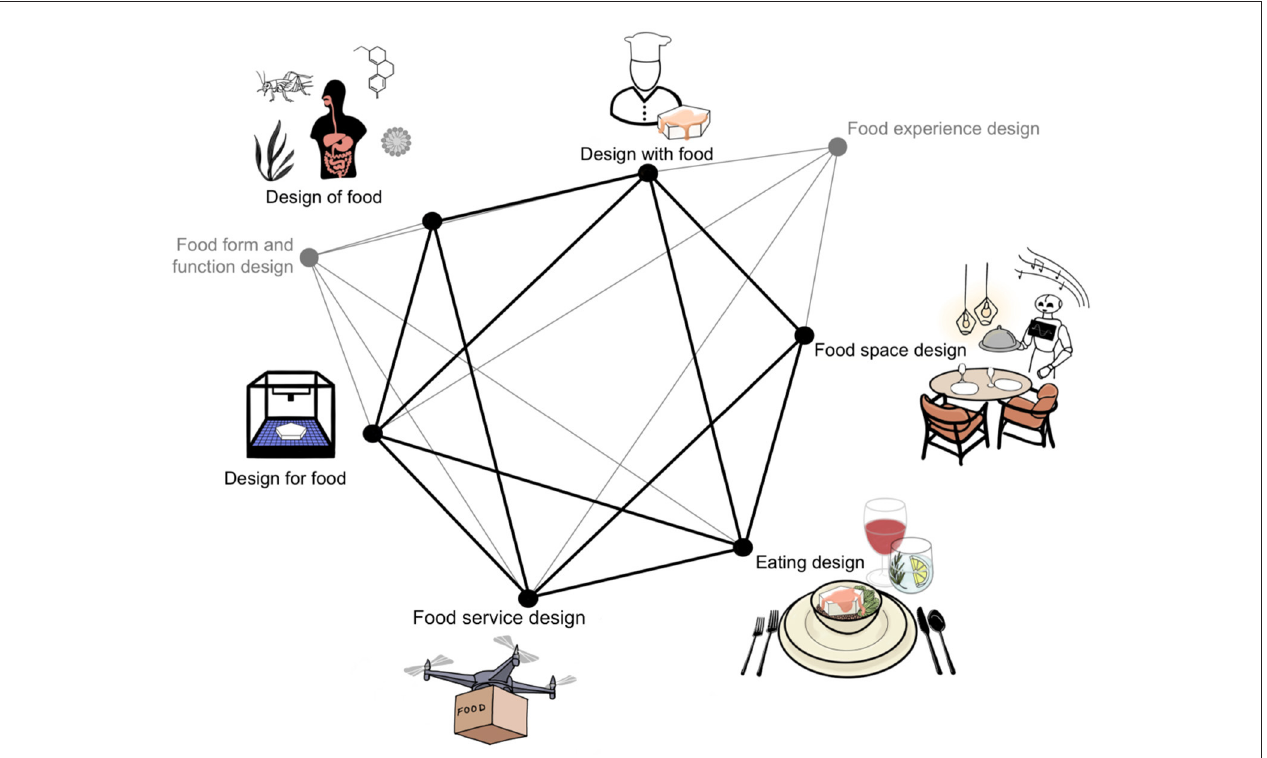
FIGURE 4 | Neural network graphical representation of the major disciplines (black dots) in the food design concept and their interconnections. Sub-disciplines arising through communion of ideas of some major disciplines indicated by gray